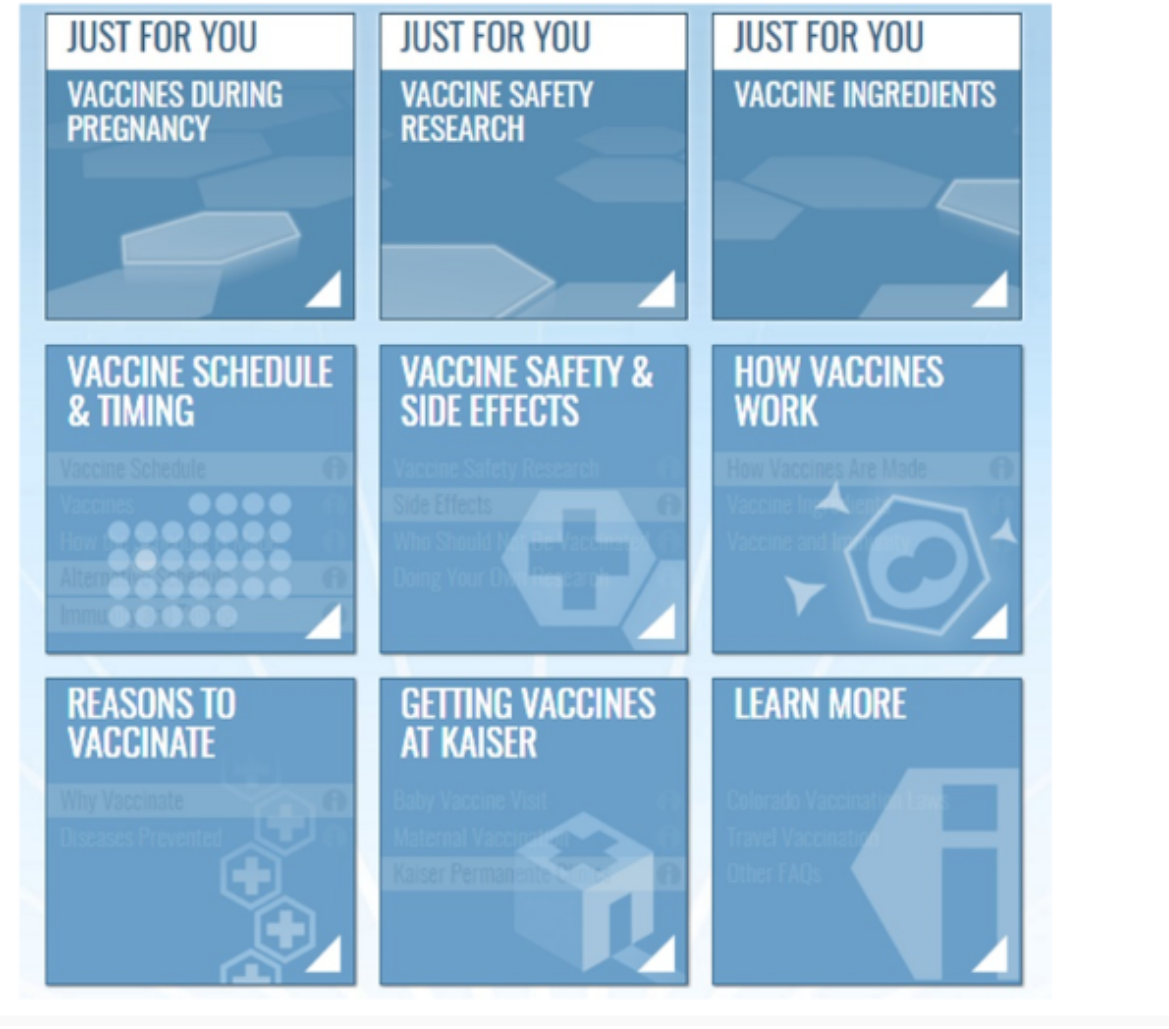
Figure 3. Architecture of the Final Tailored Intervention - Vaccines and Your Baby Home